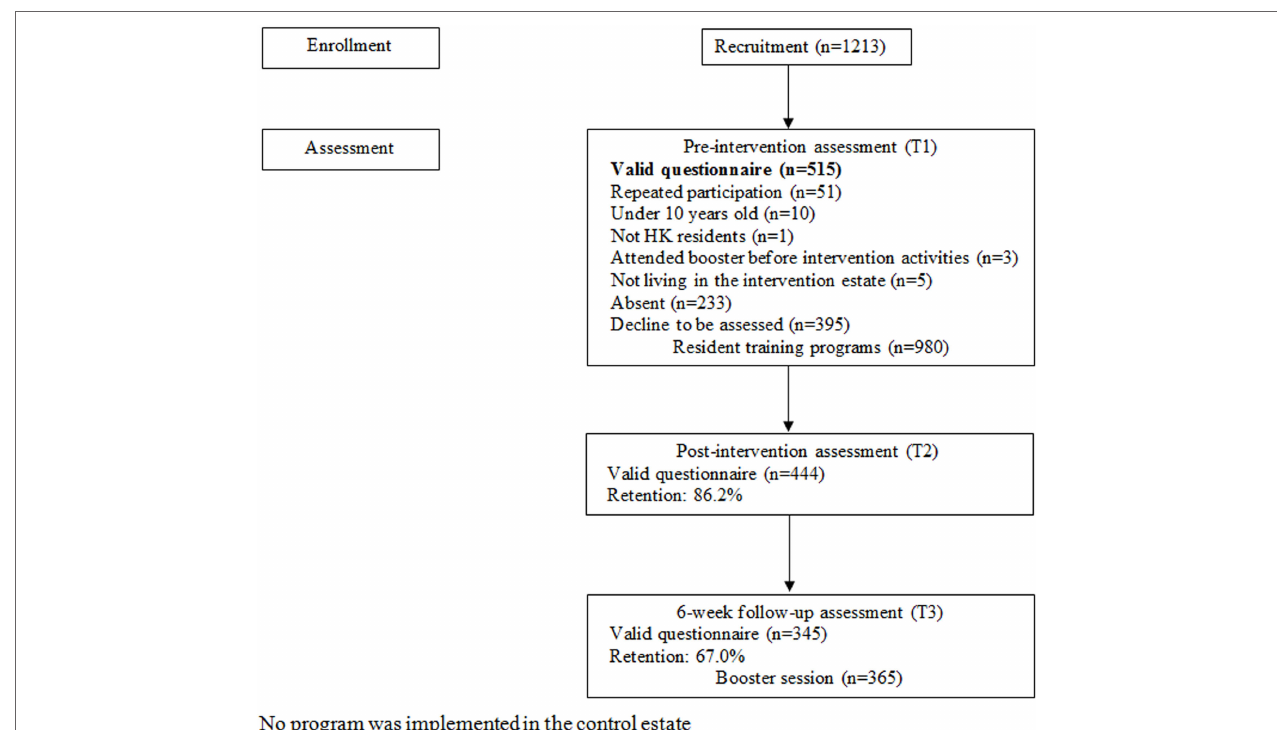
FigUre 2 | The flow diagram of participants in the intervention